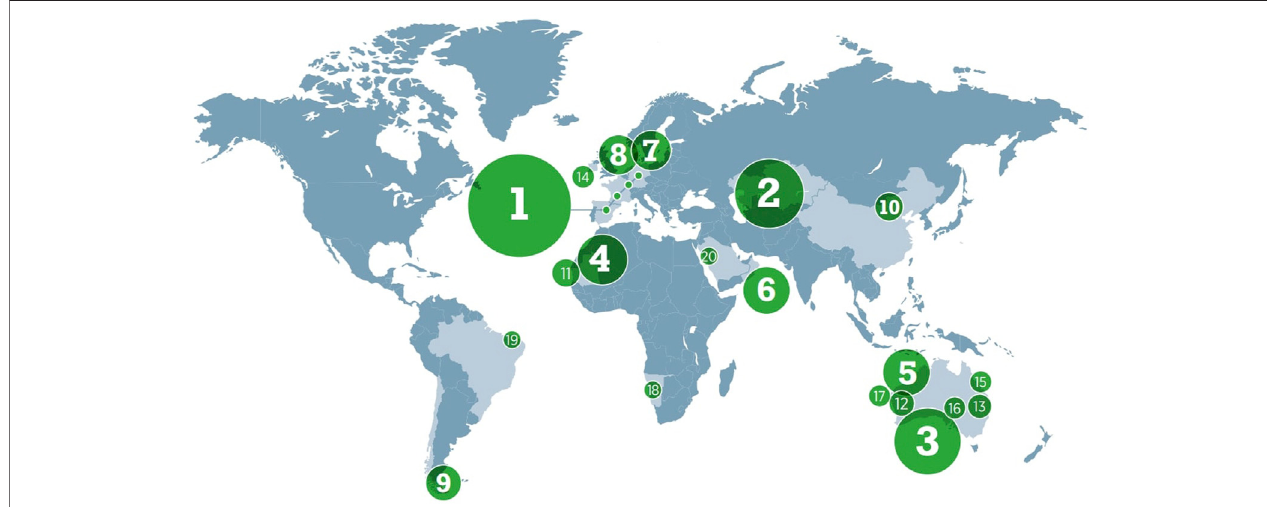
FIGURE 2 | The world ’ s 20 largest announced giga-scale green hydrogen projects. HyDeal Ambition (67 GW) — Western Europe (1); Unnamed (30 GW) — Kazakhstan(2);WesternGreenEnergyHub(28 GW) — Australia(3);AMAN(16 GW)a – Mauritania(4);AsianRenewableEnergyHub(14 GW) — Australia(5);OmanGreen Energy Hub (14 GW)a – Oman (6); AquaVentus (10 GW) — Germany (7); NortH2 (10 GW) — Netherlands (8); H2 Magallanes (8 GW) — Chile (9); Beijing Jingneng (5 GW) — China (10); Project Nour (5 GW)a – Mauritania (11); HyEnergy Zero Carbon Hydrogen (4 GW)a – Australia (12); Paci fi c solar Hydrogen (3.6 GW) — Australia (13); Green Marlin (3.2 GW) — Ireland (14); H2-Hub Gladstone (3 GW) — Australia (15); Moolawatana Renewable Hydrogen Project (3 GW)a – Australia (16); Murchison Renewable HydrogenProject (3 GW) — Australia (17);Unnamed(3 GW) — Namibia(18);Base One(2 GW)a – Brazil(19);HeliosgreenFuelsProject(2 GW) — SaudiArabia (20) (IRENA,